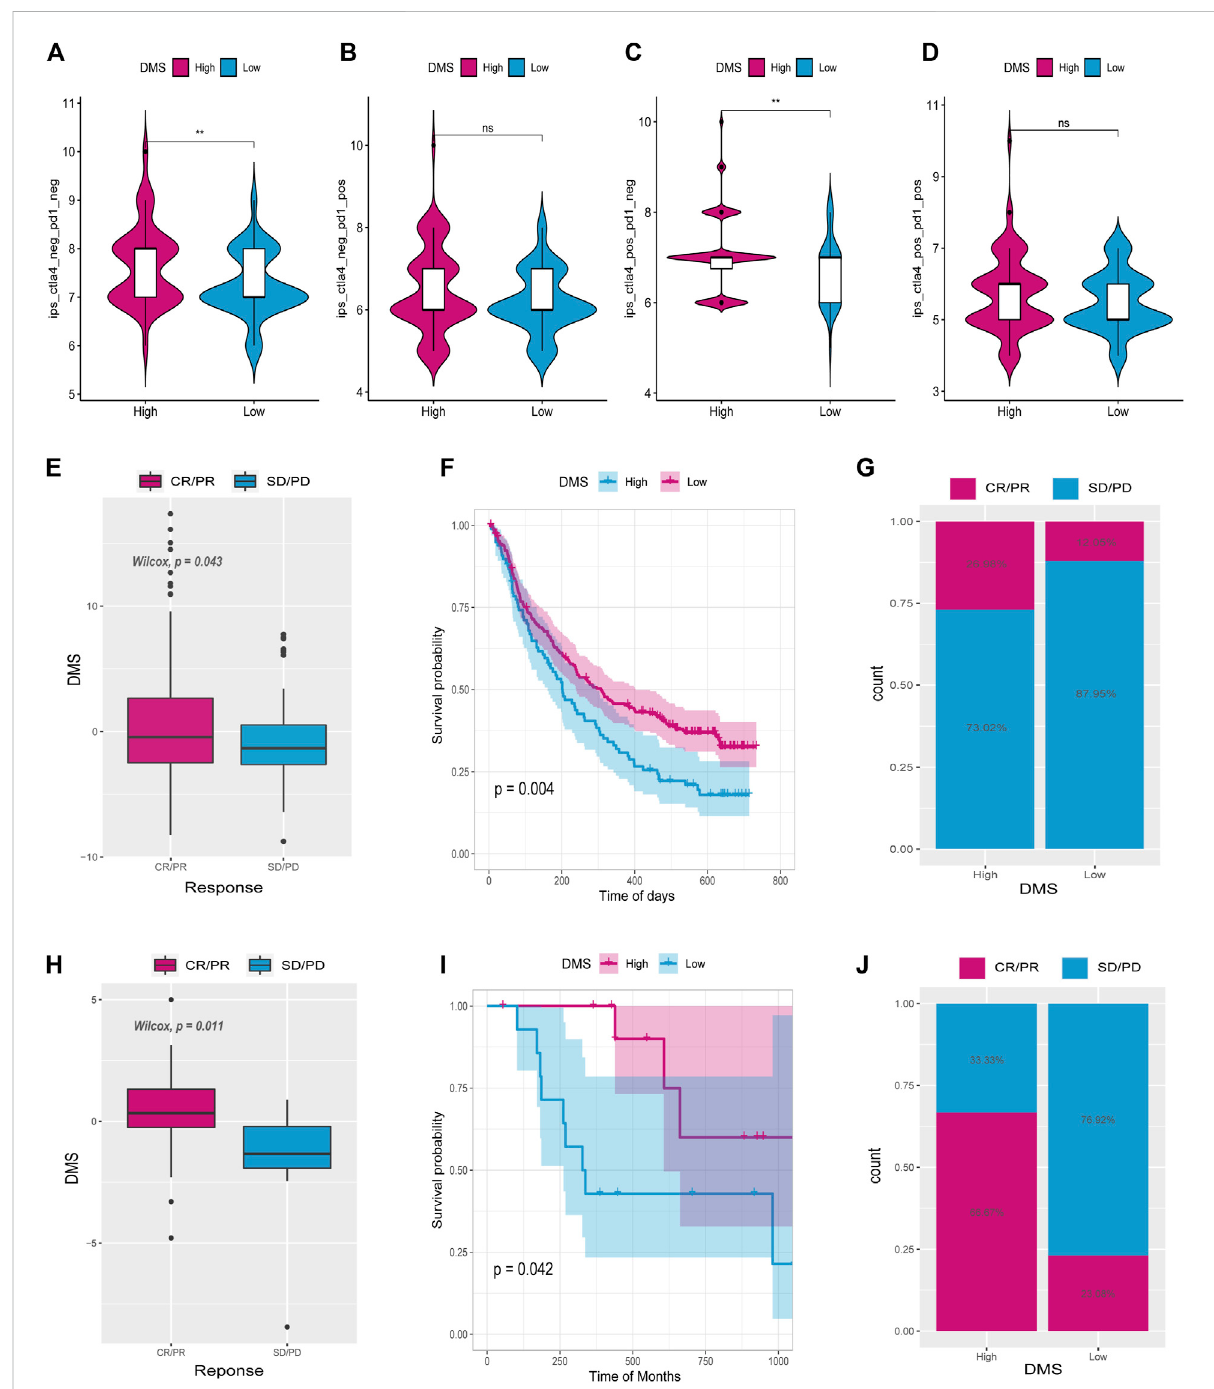
FIGURE 10 TumorDNAmethylationscore(DMS)asapredictorofimmunotherapeuticbene fi t.Immunophenoscore(IPS)differencesbetweenhighandlow DMS groups (A – D) . E and H show the difference in ICI scores between IMvigor210 and GSE78220 cohorts. (F,I) Survival curves for high and low ICI score groups in IMvigor210 and GSE78220 cohorts, respectively. (G,J) Differences between high and low ICI score groups in IMvigor210 and GSE78220